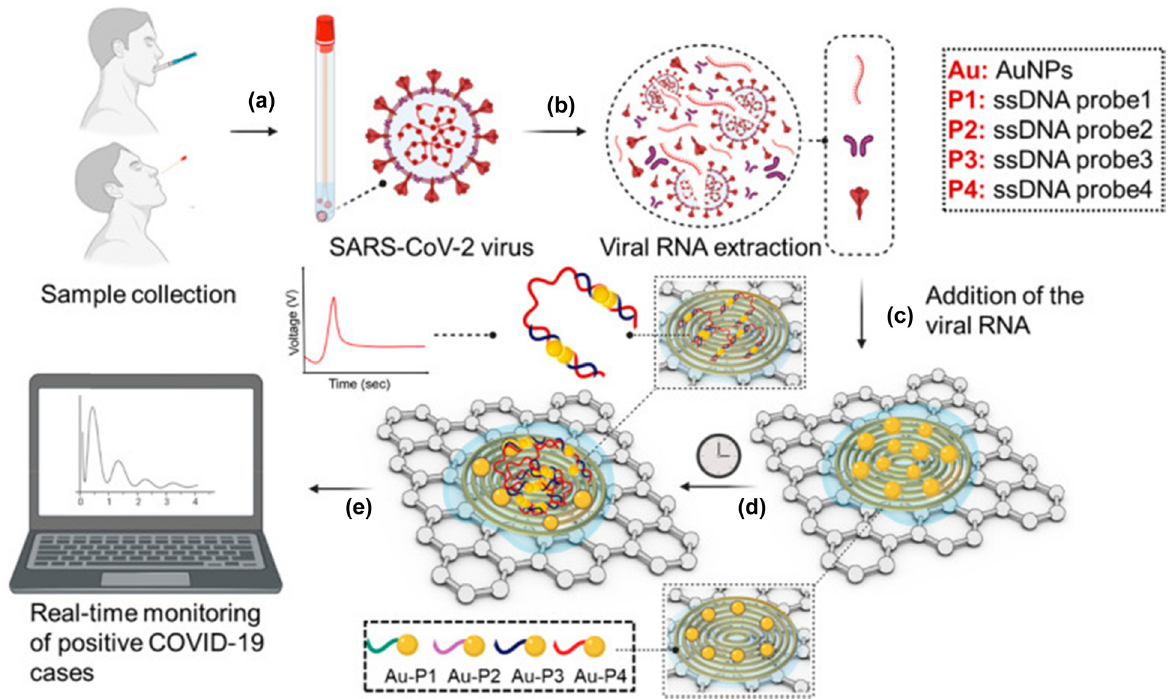
Figure 19: Schematic representation of the operation principle of the COVID - 19 electrochemical sensing platform ( a ) the infected samples will be collected from the nasal swab or saliva of the patients under observation; ( b ) the viral SARS - CoV - 2 RNA will be extracted; ( c ) the viral RNA will be added on top of the graphene - ssDNA - AuNP platform; ( d ) incubation of 5 min; and ( e ) the digital electrochemical output will be recorded [ 118 ]